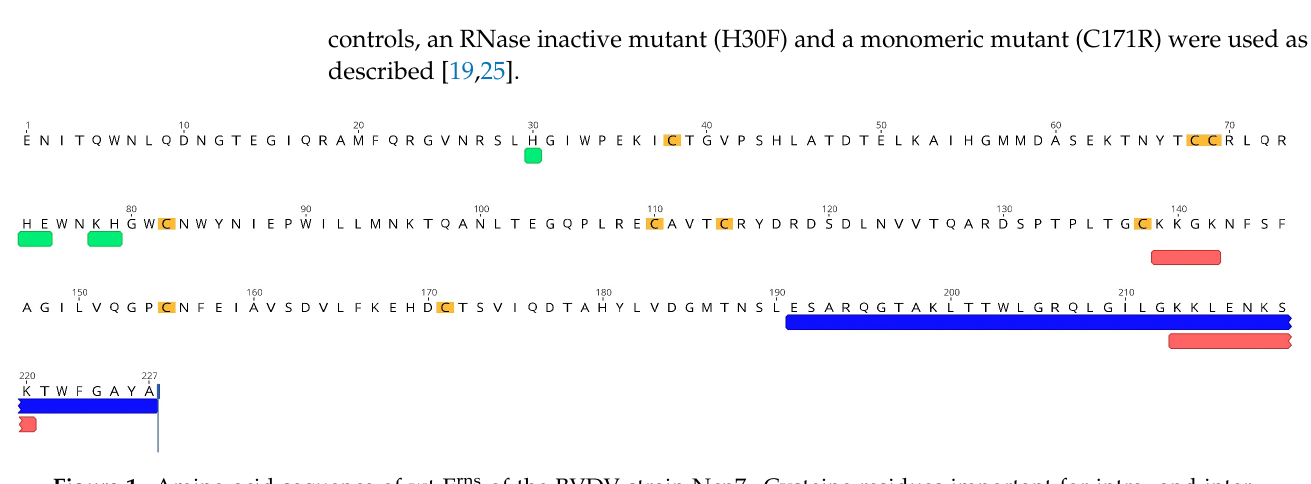
Figure 1. Amino acid sequence of wt E rns of the BVDV strain Ncp7. Cysteine residues important for intra- and inter-molecular disulfide bridges (C171 for the latter) are highlighted in yellow. Residues reported to be part of the RNase active site are underlined in green, while the two conserved positively-charged regions are underlined in red (PR: 139 KKGK 142 , and HBD: 213 KKLENKSK 220 ; compare Table 1). The last 37 amino acids at the C-terminus (which contain the amphipathic helix and the HBD) that were removed in the E rns - Δ C-term mutant are underlined in blue. Table 1. Description of the E rns mutants applied in the study. Various mutants of the two potential heparin-binding sites, 139 KKGK 142 (termed “positive region”, PR; numbering according to Figure 1) and 213 KKLENKSK 220 (termed “heparin-binding domain”, HBD), were generated by substitution of positively charged lysines (K) with neutral alanines (A). In addition to the full mutants ( 139 AAGA 142 and 213 AALENASA 220 ) with all lysines changed, single or double site-mutants were constructed. To distinguish all these PR-(left columns) and HBD-(right columns) mutants, a code of 1 for lysine and 0 for alanine was used in the names of each of the corresponding mutant (sites mutated are underlined in the